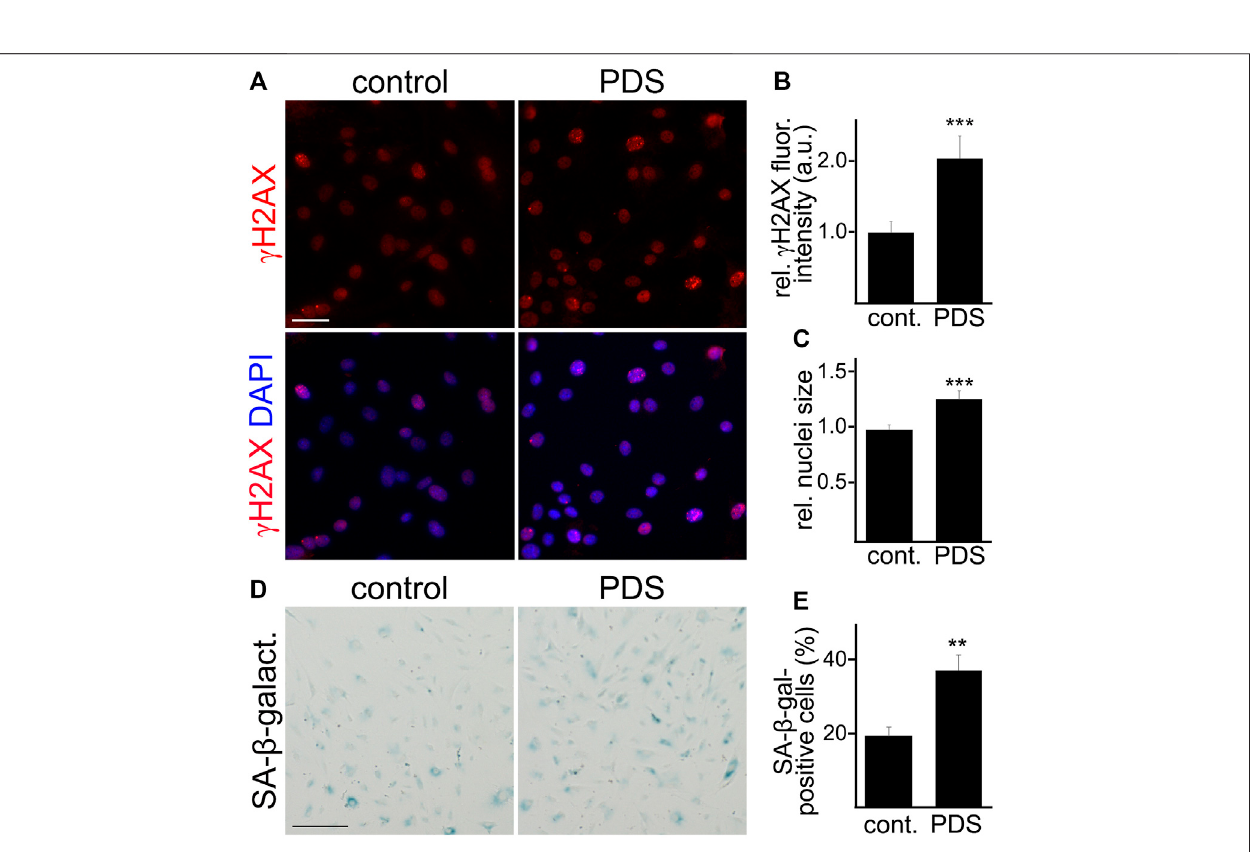
FIGURE 3 | A G4-stabilizing compound exacerbated senescence-associated phenotypes in cultured CEC. (A) CEC isolated from aged (18 – 20 m/o) female mice andcultured weretreatedwithpyridostatin (0.5 µM),oravehicle(water),for4 days.CECwere fi xedandstainedwithantibodiesagainst γ H2AXandthenuclearHoechst dye (DAPI channel). Scale bar, 50 µm (B) Quanti fi cation of the fl uorescence intensity of γ H2AX from (A) . t -test, *** p -value (cid:2) 0.0003. Data were pooled from three independent experiments analyzing 50 cells per condition and experiment. (C) Quanti fi cation of the nuclei size. t -test, *** p -value (cid:2) 0.0001. Data were pooled from three independent experiments analyzing 50 cells per condition and experiment. (D) CEC isolated from aged (18 – 20 m/o) female mice and cultured were treated with pyridostatin (0.5 µM), or a vehicle (water), for 4 days. CEC were fi xed and stained with the SA- β -galactosidase staining kit. Scale bar, 50 µm. (E) Quanti fi cation of the percentage of SA- β -galactosidase-positive cells. t -test, ** p -value (cid:2) 0.0015. Data were pooled from three independent experiments analyzing 50 cells (A – C) or 20 microscopic fi elds (D , E) per condition and experiment.